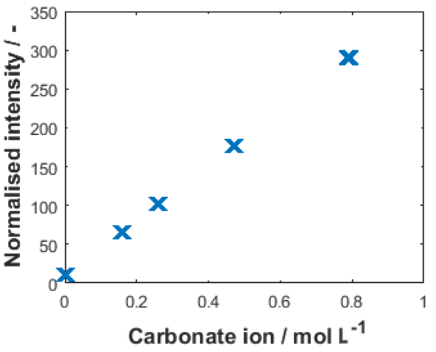
− 2 concentration 3